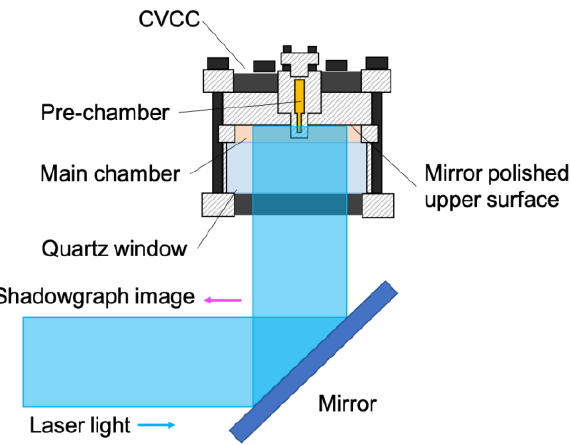
Fig. 5. Detailed view of the double path type shadowgraph optics and the bottom-up optical